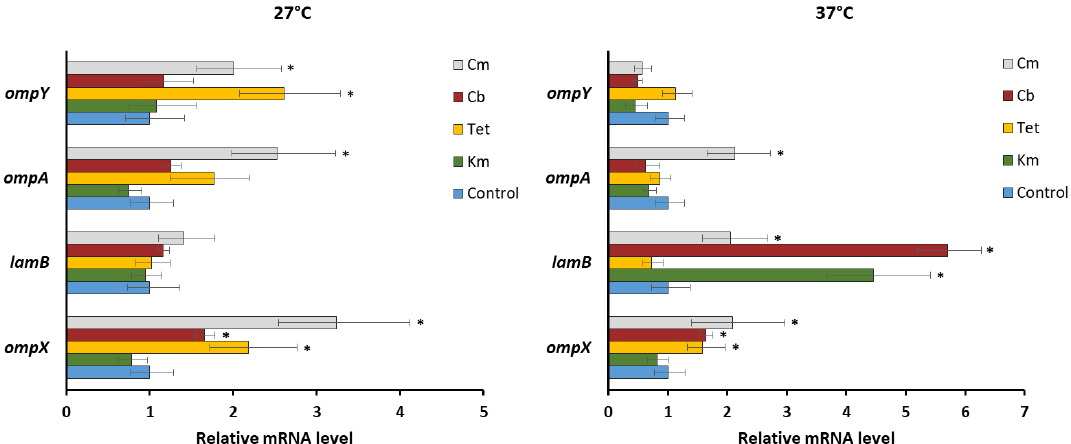
Figure 4. Relative expression levels of Y. pseudotuberculosis ompX , lamB , ompA , and ompY under prolonged antibiotic stress detected by qRT-PCR. All results are expressed as mean ± standard deviation from three independent experiments. An asterisk indicates p -value < 0.05 vs. respective untreated control. Significance was calculated using one-way ANOVA.